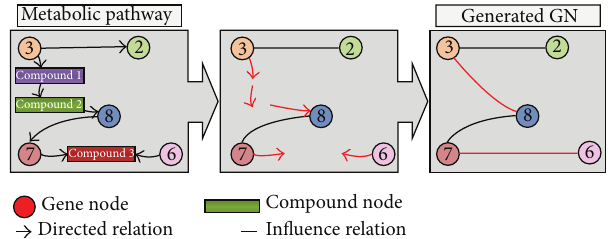
Figure 2: The simplest conversion example. In the first substep the compound nodes and the direction of the relationship edges are removed. In the second substep, new association relationships are established.